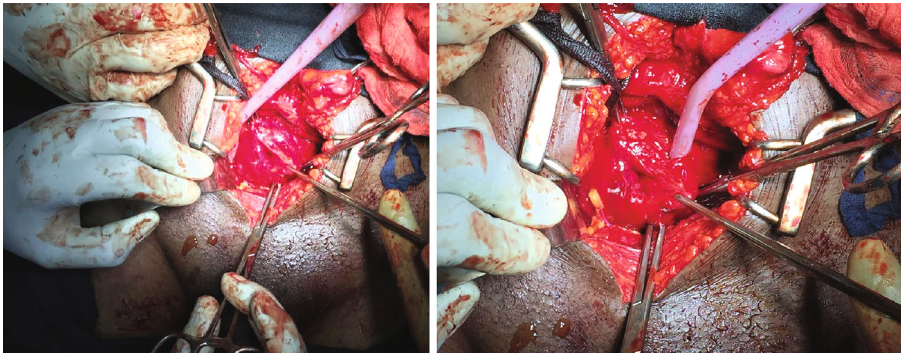
Figure 3: Open surgical repair of multiple bladder